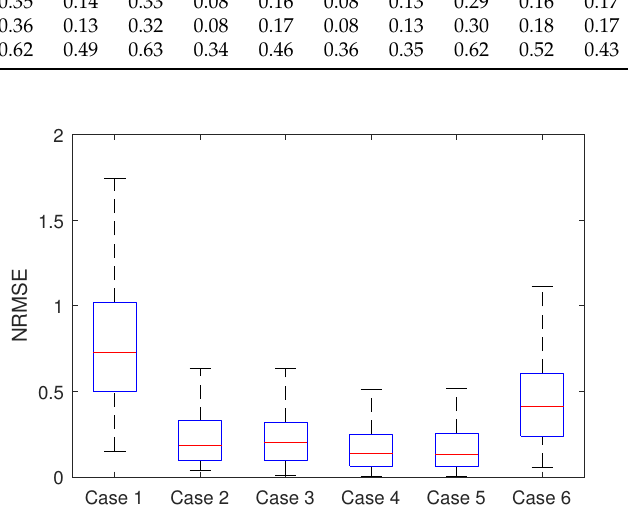
Figure 6. Boxplot of imputation NRMSE for each imputation